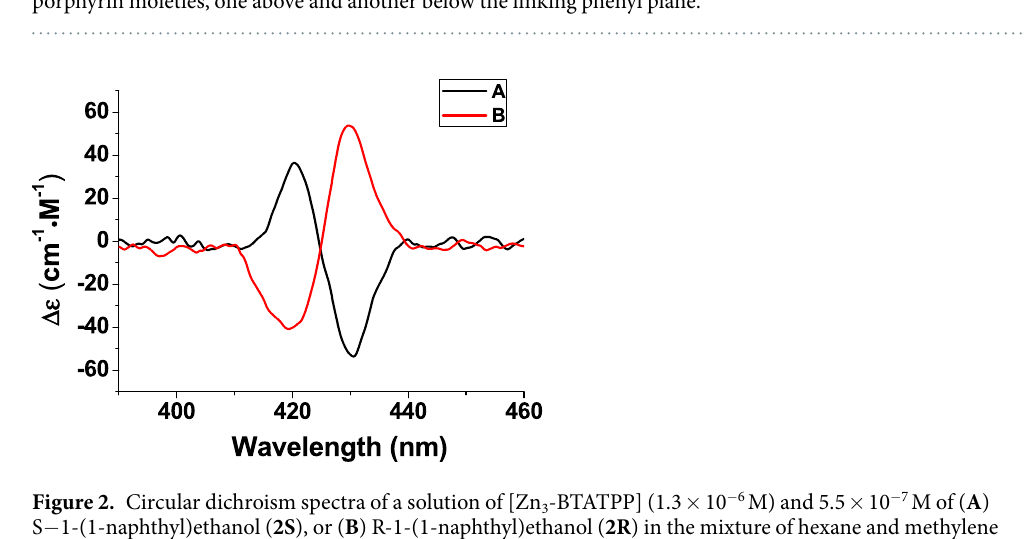
Figure 1. The structural formula of the host and guests. The host shows two “spaces” surrounded by three porphyrin moieties, one above and another below the linking phenyl plane.